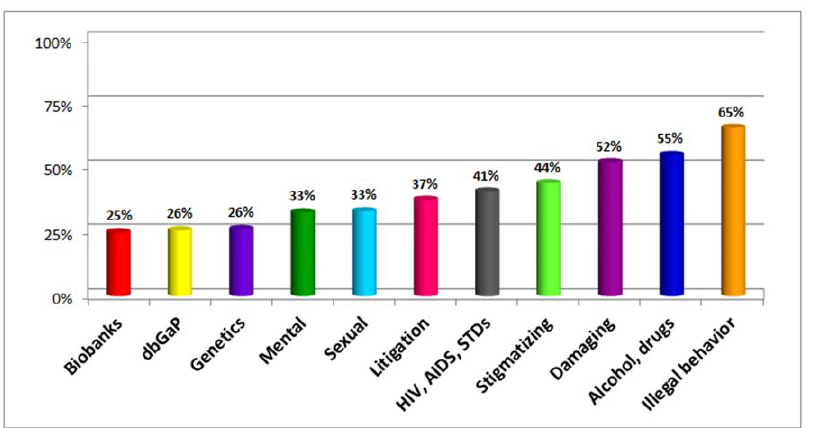
Figure 2. ‘‘For which of the following research activities would your IRB typically require or recommend that the investigator apply for a Certificate?’’. *Survey respondents were instructed to ‘‘Assume in each case that identifiable data will be collected.’’. Key: Biobanks : Studies that collect and store biospecimens and associated data for future research use. dbGaP : Research involving depositing data in centralized repositories for widespread sharing (e.g., placing data from genome-wide association studies into NIH’s Database of Genotypes & Phenotypes (dbGaP). Genetics : Genetic research. Mental : Research on participants’ psychological wellbeing or mental health. Sexual : Research on participants’ sexual attitudes, preferences, or practices. Litigation : Research where the topic under study could be the subject of litigation (e.g., breast implants, environmental or occupational exposures). HIV/AIDS/STDS : Research on HIV, AIDS, or other STDs. Stigmatizing : Research involving information that might lead to social stigmatization or discrimination. Damaging : Research that gathers information that could be damaging to a participant’s financial standing, employability, or reputation. Alcohol, drugs : Research on the use of alcohol, drugs, or other addictive products. Illegal : Research that collects information on illegal